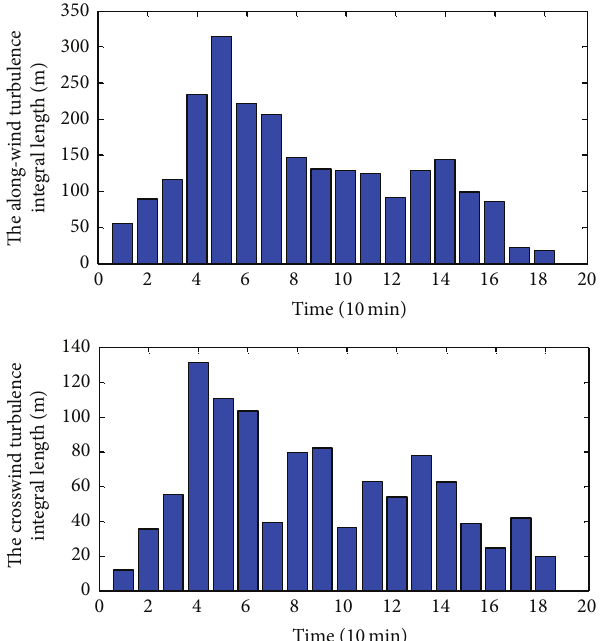
Figure 11: Turbulence integral length scale of Typhoon Fung-Wong.